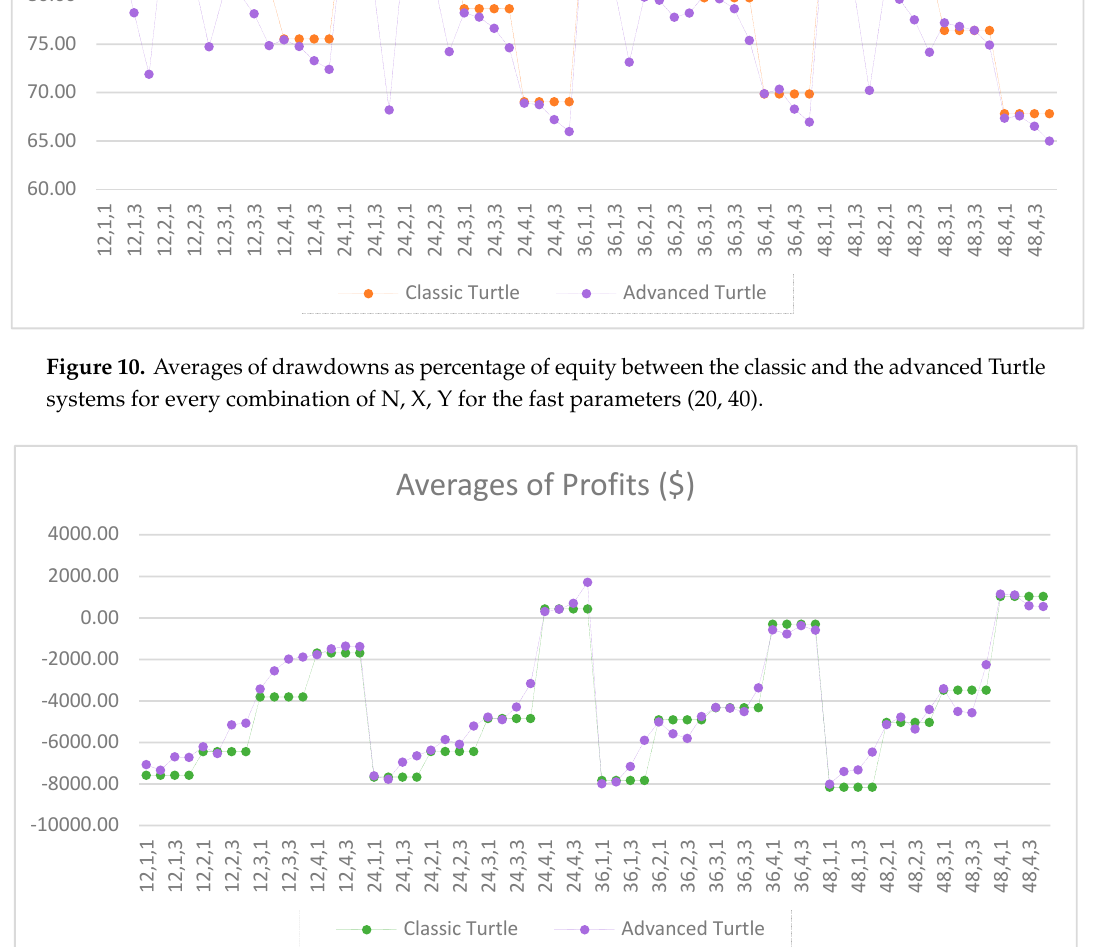
Figure11. AveragesofprofitsbetweentheclassicandtheadvancedTurtlesystemsforeverycombination Figure 11. Averages of profits between the classic and the advanced Turtle systems for every of N, X, Y for the medium parameters (40, combination of N, X, Y for the medium parameters (40, 80).